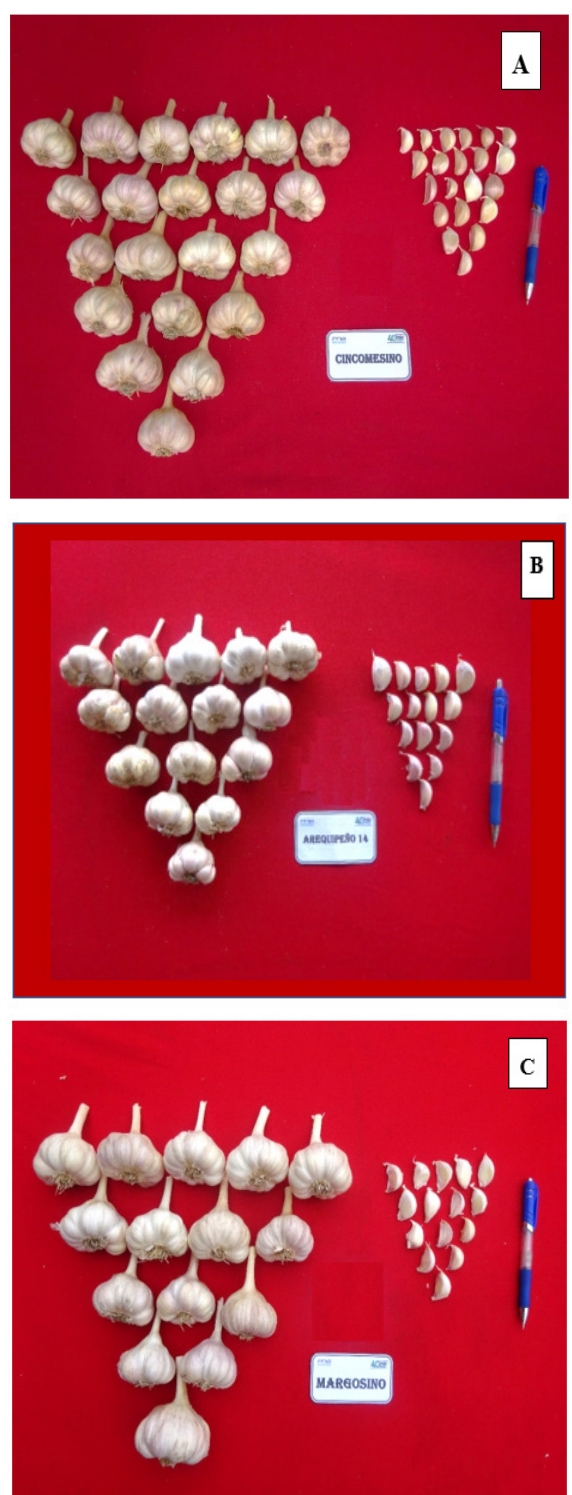
Figure 1. Bulbs and cloves of three garlic cultivars, first